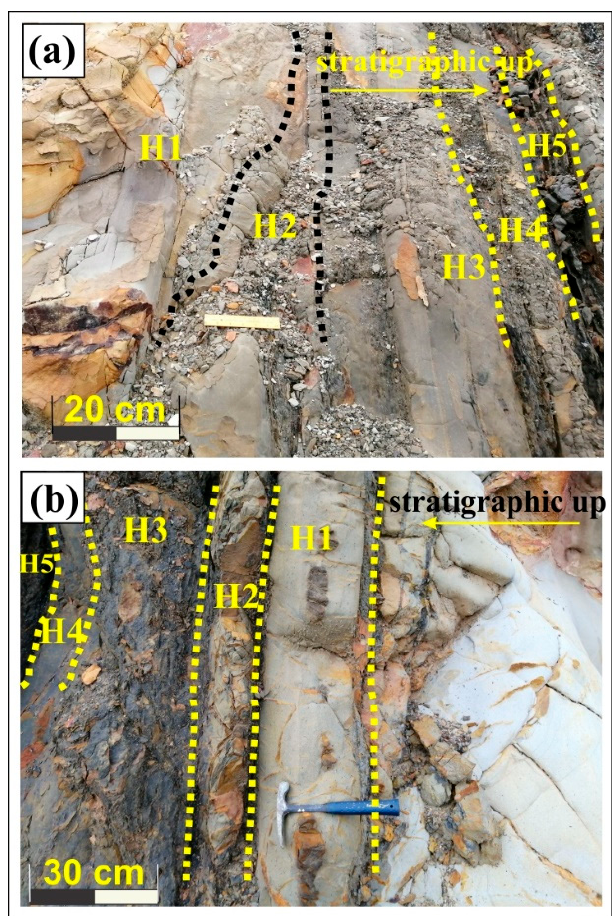
Figure 6. Hybrid bed facies in a medial lobe setting. ( a ) A complete model of hybrid facies is commonly developed in the medial lobe system, where all the facies are distinctively placed in hybrid event beds. One can easily find facies ranging from H1 to H5 from the base to the top, respectively, in the medial lobe exposed in the Sepangger (SP) section, NW Sabah. ( b ) All hybrid event bed facies (H1 to H5) are developed in the medial lobe component exposed in the Jalan UMS behind the KFC (JK) section, West Sabah.